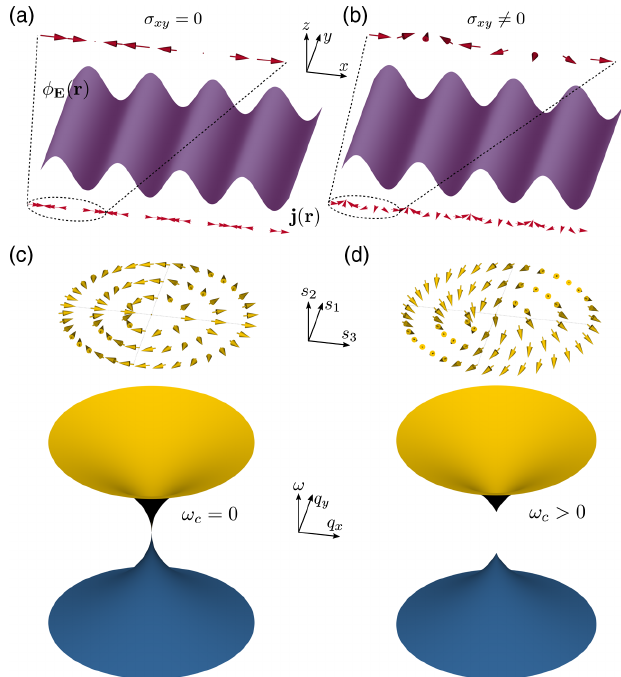
FIG. 1. Plasmon dispersion and internal current density texture. (a),(b) Current density (vector) fields j ð r Þ configuration 0 and σ ≠ 0 , respectively. Note that for plasmons with σ xy ¼ xy while electric potential ϕ E ð r Þ take on the same longitudinal electric profile, j ð r Þ adopts a completely different texture. 0 ), Plasmon dispersion for (c) conventional plasmon ( ω c ¼ ≠ 0 ) in a two-dimensional and (d) magnetoplasmon modes ( ω c metal [Eq. (5)], both in the nonretarded limit. Current density > 0 exhibits a nontrivial canted pseudospinor [Eq. (7)] for ω c 0 , pseudospinor winds only in the ð s texture; when ω 1 ; s 3 Þ c ¼ plane. Blue band is a complex-conjugate copy of primary plasmon band (see